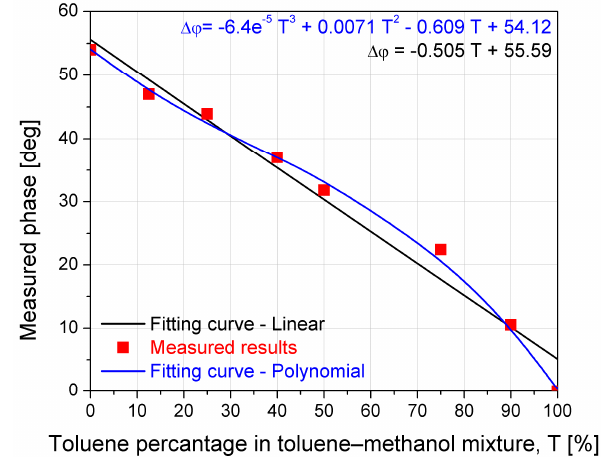
Figure 12. Measurement of the toluene concentration in toluene–methanol mixture: sensor measured response (dots) and the corresponding fitting curves (lines) with equations.